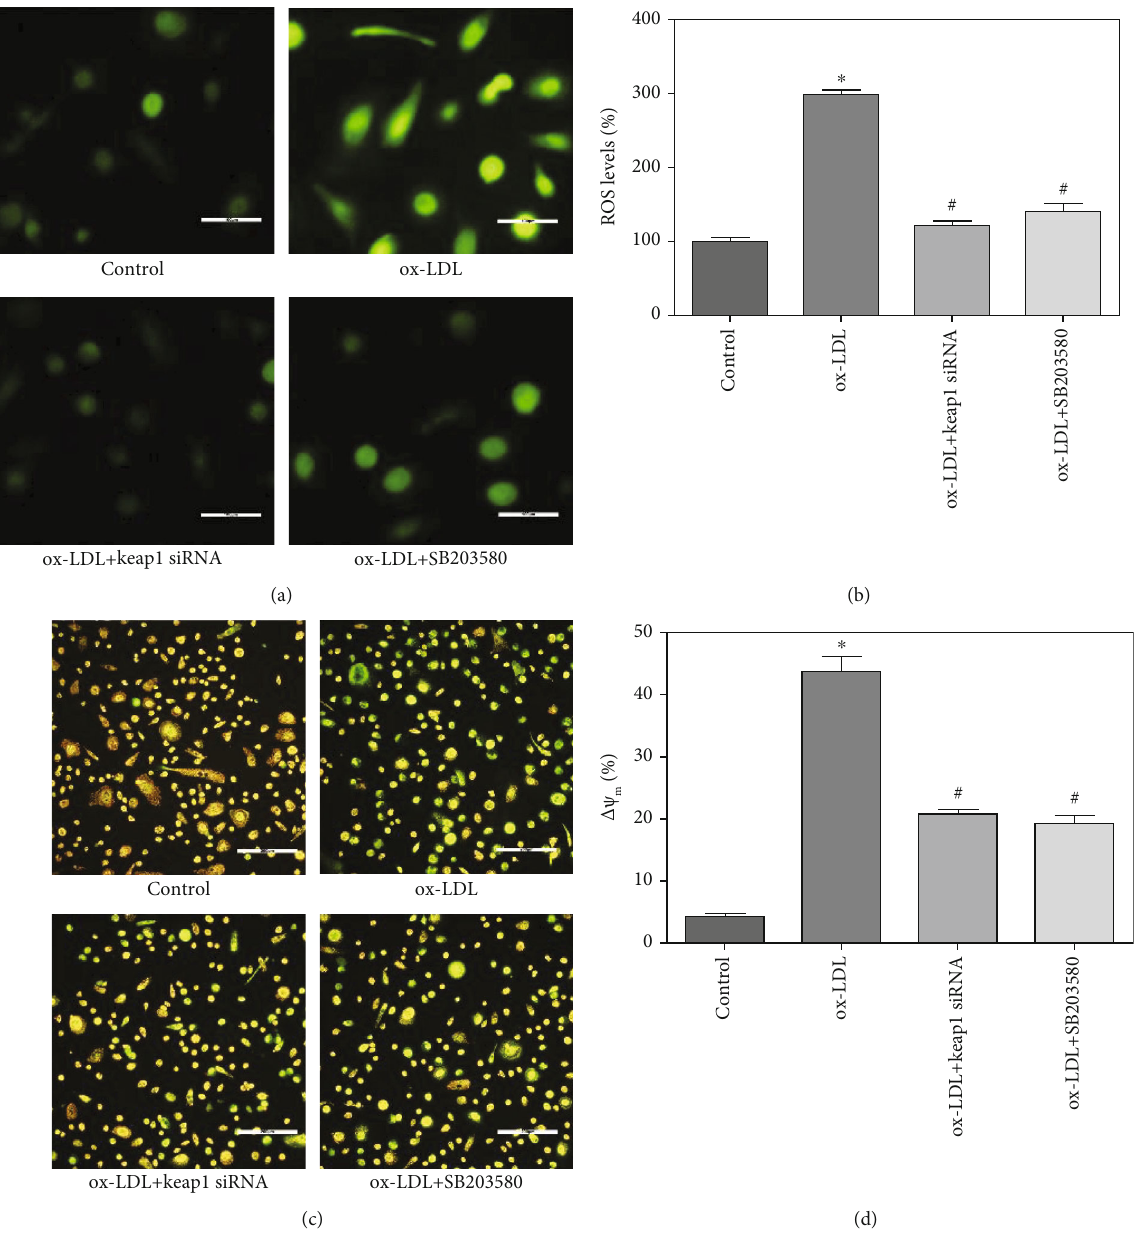
Figure 3: Nrf2 mediated ox-LDL-induced EPC oxidative stress and mitochondrial dysfunction. After being pretreated with Keap1 siRNA